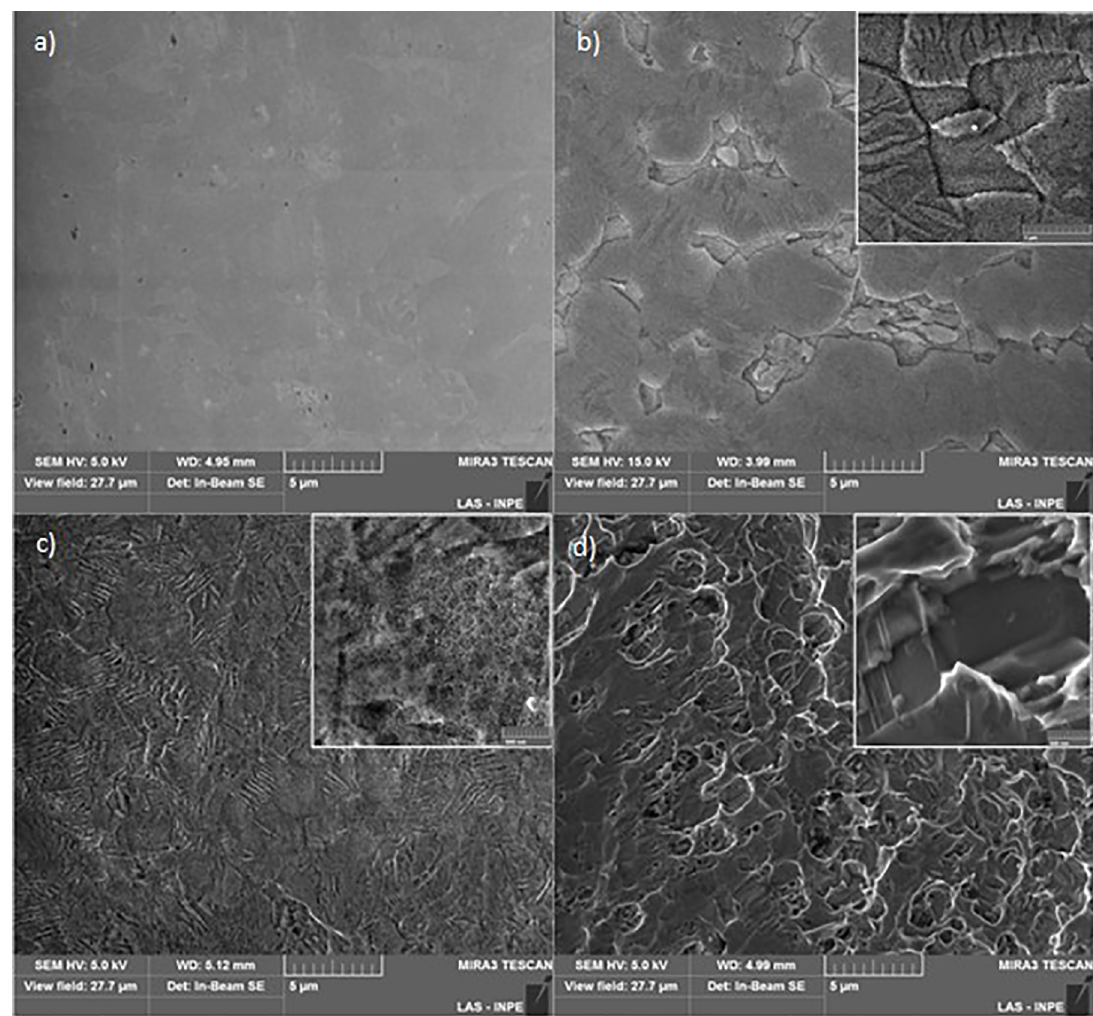
Figure 7 . SEM images (10,000×) of polished Ti6Al4V samples. (a) untreated control and (b–d) samples etched by piranha solution for 30 min at 25 °C, 40 °C, and 60 °C, respectively. Insets show high-resolution images of nanotextures in